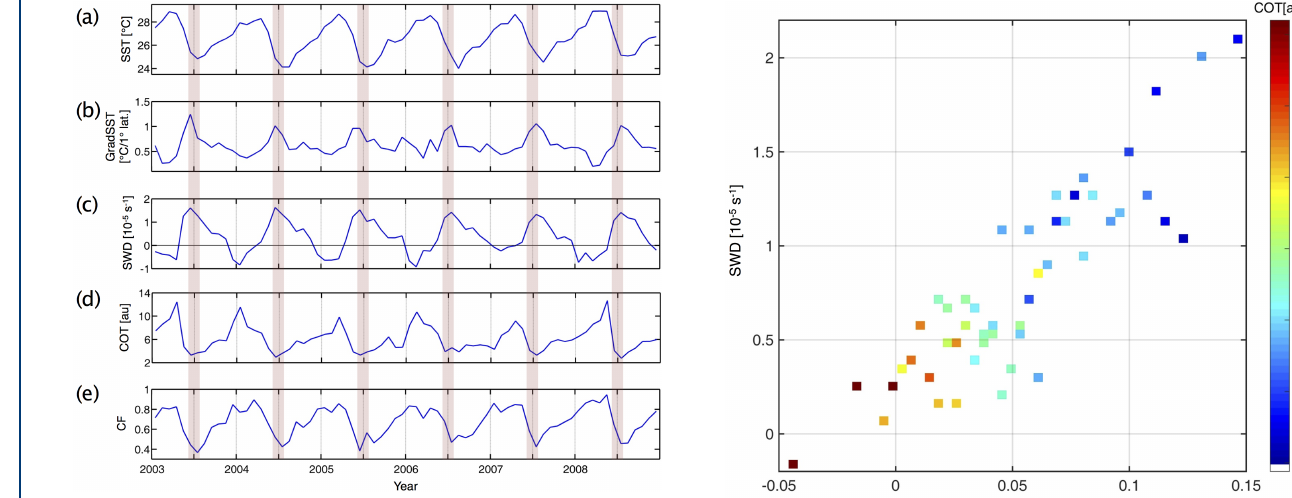
Figure 7. Mean monthly time series (2003–2008) of oceanic and atmospheric dynamic state and cloud properties along the equa- torial Atlantic (latitudes/longitudes: 0–2 ◦ N/20–10 ◦ W). The pre- sented fields are (a) sea-surface temperature (SST), (b) meridional gradient of SST, (c) surface wind divergence (SWD), (d) total cloud optical thickness (COT), and (e) daytime cloud cover fraction (CF, in normalized units between 0 and 1).